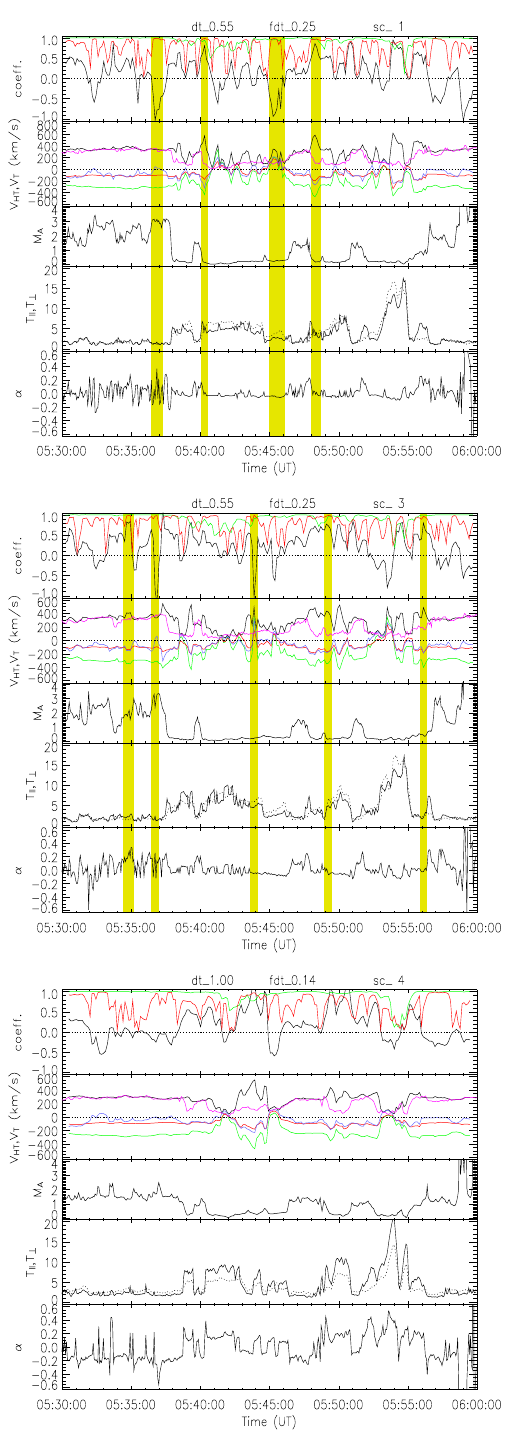
Fig. 8. Sc1 (top), sc3 (middle) and sc4 (bottom) observations of various plasma parameters between 05:00–06:00 UT. Top panel shows observations of the slopes of the Wal´en relation (black), slopes of the deHoffmann-Teller frame (green) and magntitude of correlation coefficient of the Wal´en relation (red). The second panel shows components of the deHoffmann-Teller frame velocity: vht t (black), vht x (green), vht y (red), vht z (blue) and total plasma velocity v t (magenta). Third panel shows the Alfv´en Mach number, the fourth panel shows parallel (solid line) and perpendicular(dotted line) temperature and the fifth panel shows the value of the anisotropy factor α .